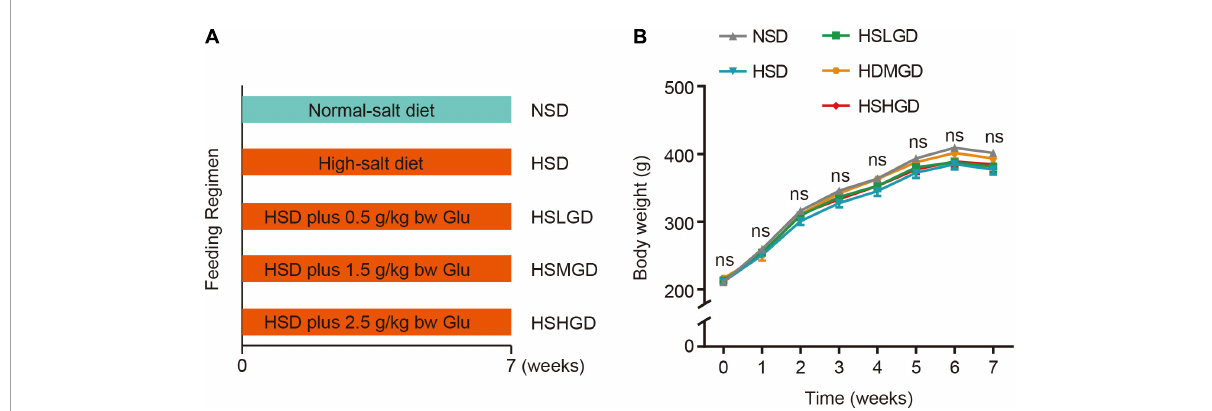
FIGURE1 Effects of dietary glutamine on body weight in salt-induced hypertensive rats. (A) Schematic outlines of the feeding regimen for the five intervention groups. Male normotensive Wistar rats aged 6 weeks were assigned to five groups: (1) Normal-salt diet (0.3% NaCl, NSD); (2) High-salt diet (8% NaCl, HSD); (3) High-salt + low-dose diet (8% NaCl, 0.5 g of L-glutamine/kg body weight, HSLGD); (4) High-salt + middle-dose diet (8% NaCl, 1.5 g of L-glutamine/kg body weight, HSMGD); (5) High-salt + high-dose diet (8% NaCl, 2.5 g of L-glutamine/kg body weight, HSHGD). (B) Body weight of rats fed on NSD, HSD, HSLGD, HSMGD, or HSHGD for 7 weeks. n = 12 (NSD, HSLGD) or 13 (HSD, HSMGD, HSHGD) rats per group. Data are presented as means ± SEM. ns, no significance. One-way ANOVA followed by Bonferroni’s post-hoc test (B)